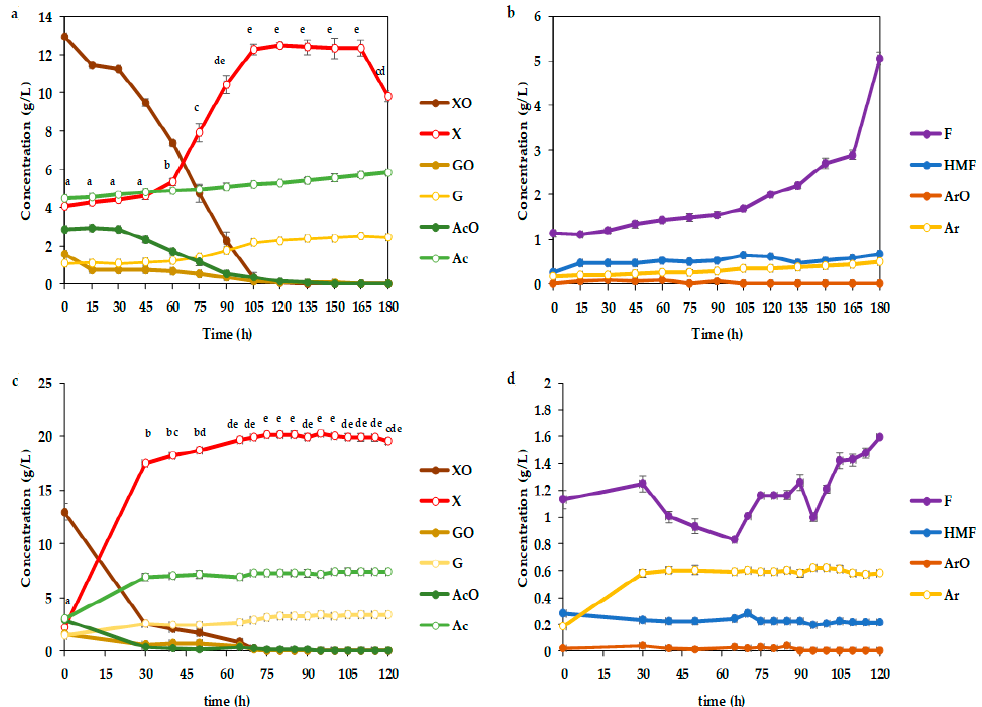
Figure 2. Hydrolysis profiles for the acid hydrolysis of hemicellulosic hydrolysates from autohydrolysis of Paulownia wood at 210 °C. ( a , b ) represent the time course for the conditions 0.5% w / w H 2 SO 4 at 125 °C and ( c , d ) for 1.5% w / w H 2 SO 4 at 115 °C. Figures represent the concentration (g/L) and standard deviation (error bars) of xylooligosaccharides (XO), xylose (X), glucooligosaccharides (GO), glucose (G), acetyl groups linked to oligomers (AcO), acetic acid (Ac), furfural (F), hydroxymethylfurfural (HMF), arabino-oligosaccharides (ArO) and arabinose (Ar). Different letters indicate significant differences ( p < 0.02) in the xylose